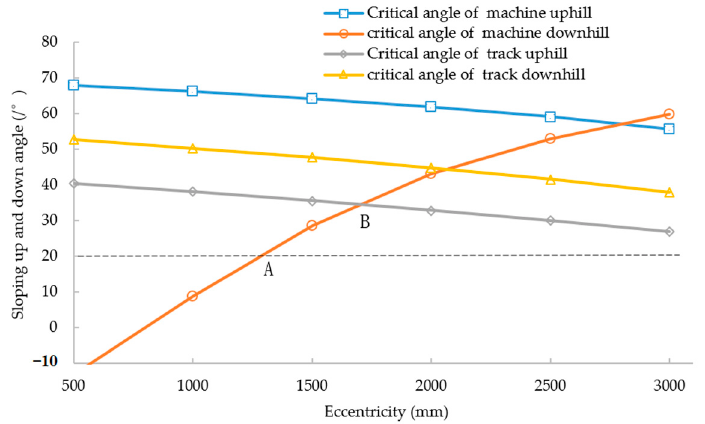
Figure 8. The maximum angle uphill and downhill.